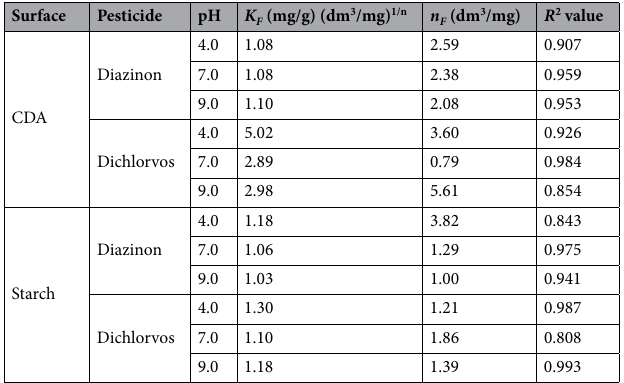
Table 3. Freundlich parameters (derived from the plots in Figs. S1 and S2 (Supplementary Information) for the adsorption of diazinon and dichlorvos on CDA and starch surfaces at 27 °C and different